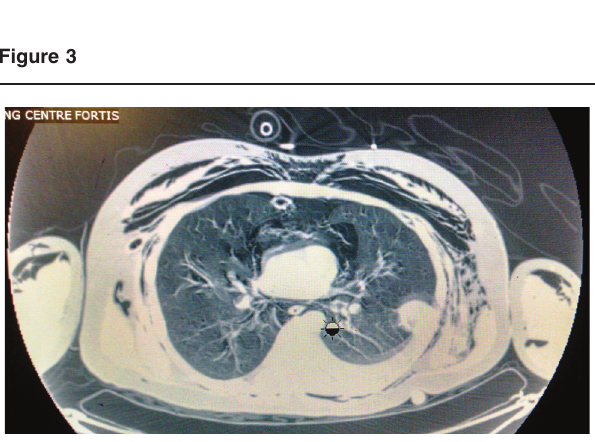
Computed tomography thorax showing pneumothorax together with pneumomediastinum and subcutaneous emphysema.